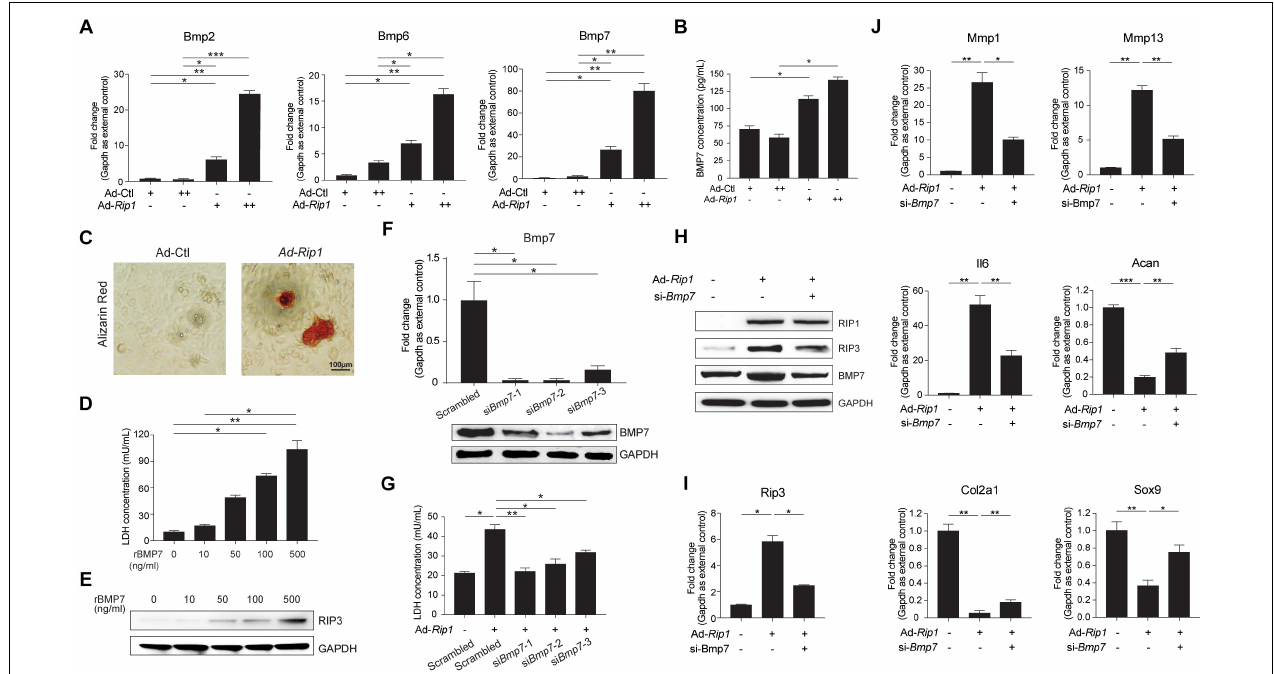
FIGURE 8 | BMP7 mediates RIP1-induced OA pathological signatures in chondrocytes. (A) The mRNA levels of Bmp2 , Bmp6 , and Bmp7 in rat chondrocytes treated with Ad-Ctl (100, 200 MOI) or Ad- Rip1 for 24 h ( n = 4 for each group; three independent experiments). (B) The concentration of secreted BMP7 in the cultural supernatant of rat chondrocytes treated with Ad-Ctl (100, 200 MOI) or Ad- Rip1 for 48 h ( n = 3 for each group; three independent experiments). (C) Alizarin red staining of rat chondrocytes treated with Ad-Ctl (100 MOI) or Ad- Rip1 for 48 h ( n = 4 for each group). (D) LDH concentration in the cultural supernatant of rat chondrocytes treated with indicated doses of recombinant BMP7 for 24 h ( n = 4 for each group). (E) The protein level of RIP3 in rat chondrocytes treated with indicated doses of recombinant BMP7 for 24 h. (F) The mRNA and protein levels of BMP7 in rat chondrocytes transfected with scrambled or BMP7-targeted siRNAs ( n = 4 for each group). (G) LDH concentration in the cultural supernatant of rat chondrocytes treated with Ad-Ctl (100 MOI) or Ad- Rip1 following by transfection of BMP7-targeted siRNAs ( n = 4 for each group). (H) The protein levels of RIP1, RIP3, and BMP7 in rat chondrocytes treated with Ad-Ctl (100 MOI) or Ad- Rip1 following by transfection of BMP7-targeted siRNA. (I) The mRNA level of Rip3 in rat chondrocytes treated with Ad-Ctl (100 MOI) or Ad- Rip1 following by transfection of BMP7-targeted siRNA ( n = 4 for each group; three independent experiments). (J) The mRNA levels of Mmp1 , Mmp13 , Il6 , Acan , Col2a1 , and Sox9 in rat chondrocytes treated with Ad-Ctl (100 MOI) or Ad- Rip1 following by transfection of BMP7-targeted siRNA ( n = 4 for each group; three independent experiments). * P < 0.05, ** P < 0.01, and *** P <